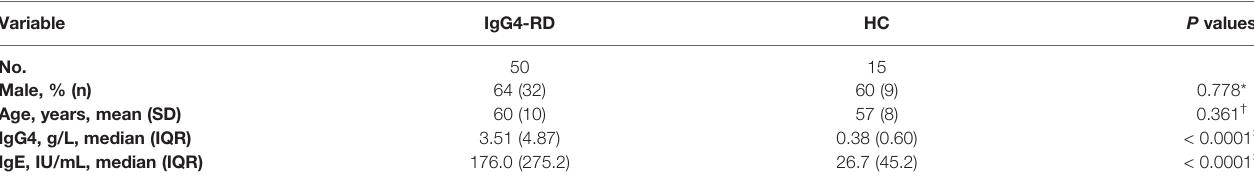
TABLE 1 | The demographics and the levles of serum IgG4 and IgE in IgG4-RD patients and healthy controls. Variable